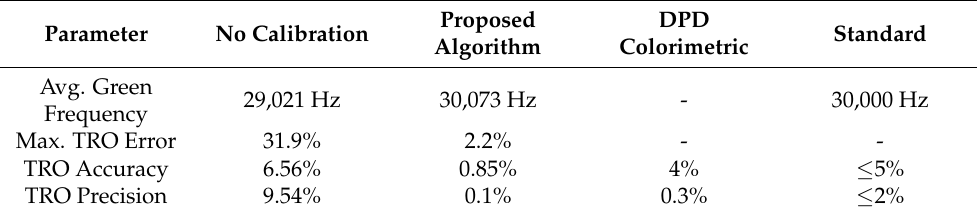
Proposed DPD Algorithm Colorimetric